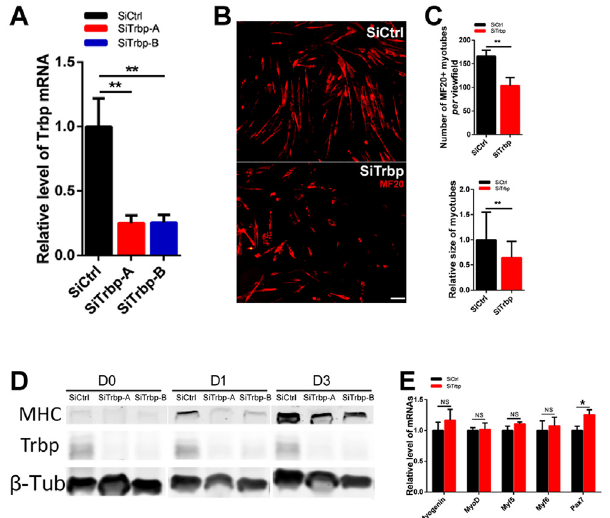
Fig 6. Trbp is required for C2C12 myoblast differentiation. (A) qRT-PCR of Trbp mRNA levels in siRNA- treated C2C12 cells (n = 3); (B) Representative images of C2C12 cells at differentiation day 3, stained with MF20 antibody. Scale bar = 80um; (C) Quantification of MF20 positive cell numbers (upper) and size of myotubes (bottom). More than 3 random view fields for each treatment were assayed. (D) Expression of myosin heavy chain (MHC) and Trbp proteins in SiCtrl or SiTrbp-treated C2C12 cells at differentiation day 0 (D0), day1 (D1) and day3 (D3). (E) qRT-PCR analysis of myogenic transcription factors in SiCtrl or SiTrbp-treated C2C12 cells at D0 (n = 3). Data are presented as Mean ± SEM. NS, not significant. * , P < 0.05. ** , P <